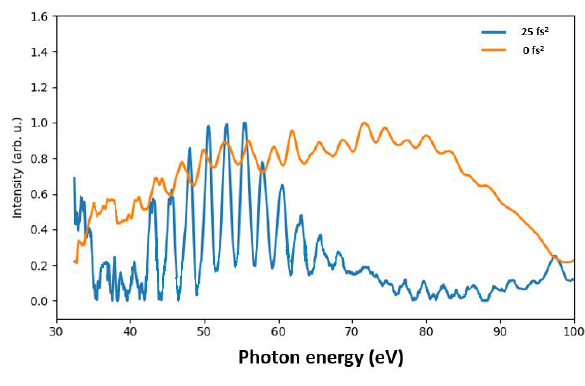
Fig 4. HHG spectra generated with post-compressed pulses with various amounts of